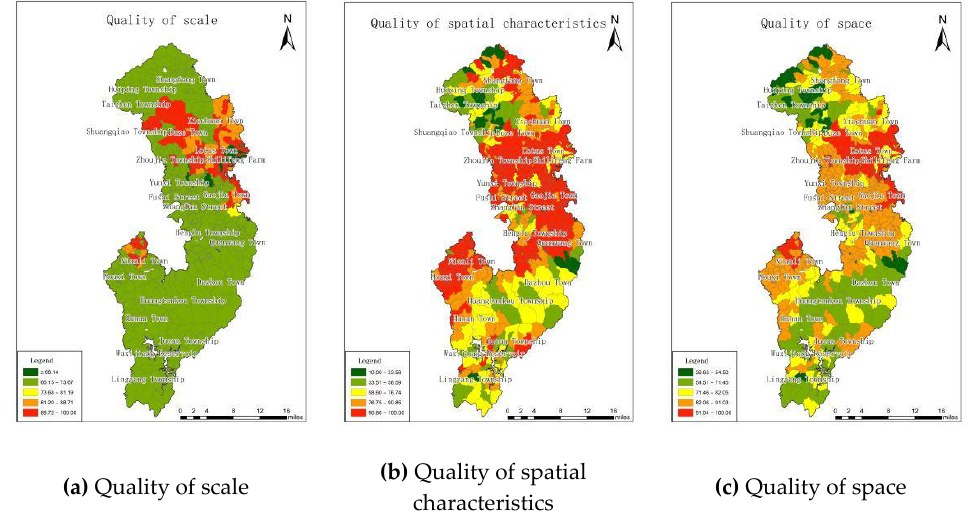
Figure 3. Scale, spatial characteristics and spatial quality evaluation of cultivated land.